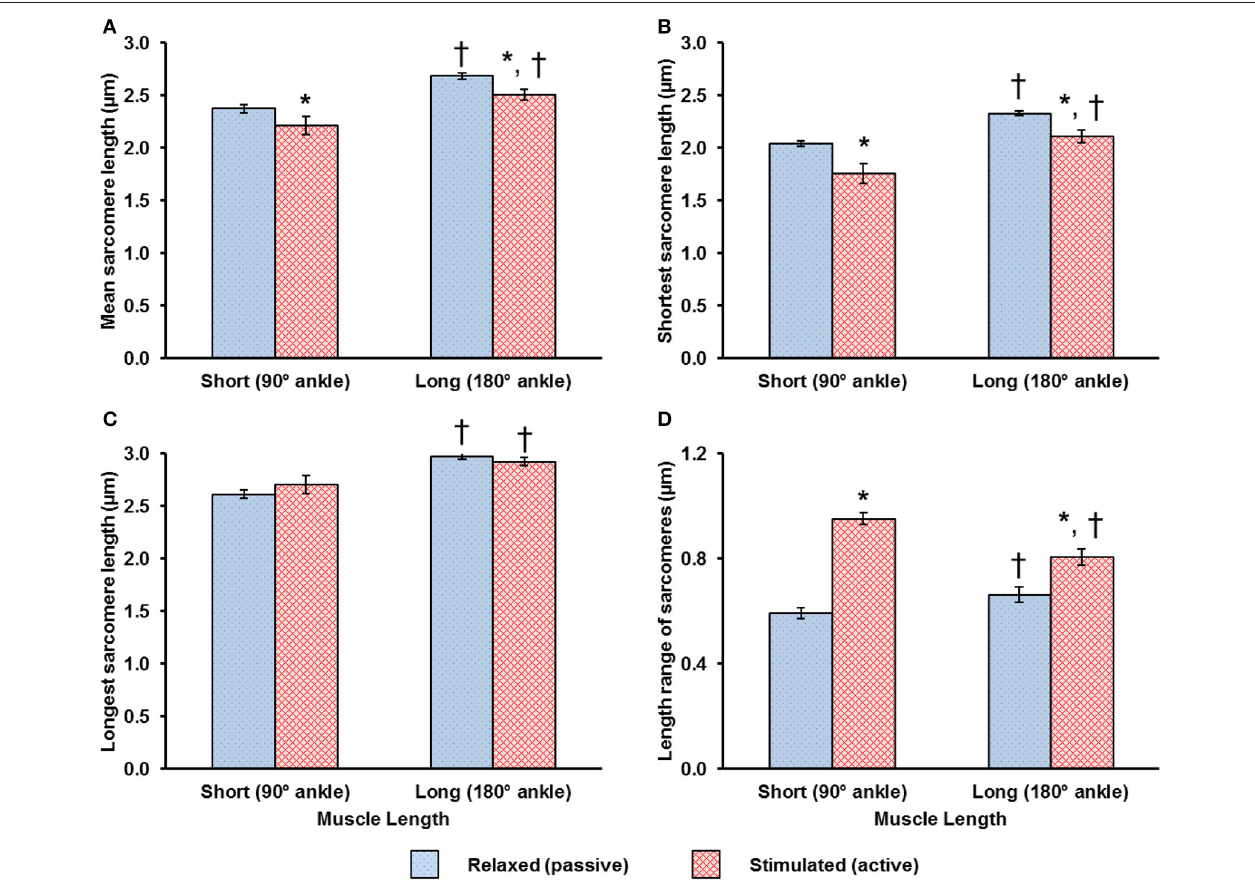
FIGURE 3 | Mean values of (A) the mean sarcomere length (SL), (B) the shortest SL, (C) the longest SL, and (D) the SL range, which is defined as the difference between the longest and the shortest sarcomere in the individual image bands. These mean values were determined from 145, 505, 132, 1,005 image bands in the relaxed-short, activated short, relaxed-long, activated-long groups, respectively (see Methods). During activation, sarcomeres shortened by 7.1 and 6.7% in muscles at the short and long lengths, respectively (A) . Sarcomere shortening during activation resulted in a decrease in the shortest SL (B) , but did not influence the longest SL (C) . As a result, the SL range increased during activation. *Indicates significant differences in mean SL, in shortest SL, in longest SL or in SL range compared with sarcomeres in the relaxed muscle at either the short or long length ( p < 0.01). † Indicates significant differences in mean SL, in shortest SL, in longest SL or in SL range compared with sarcomeres in either the relaxed or the activated muscle at the short length ( p < 0.01).